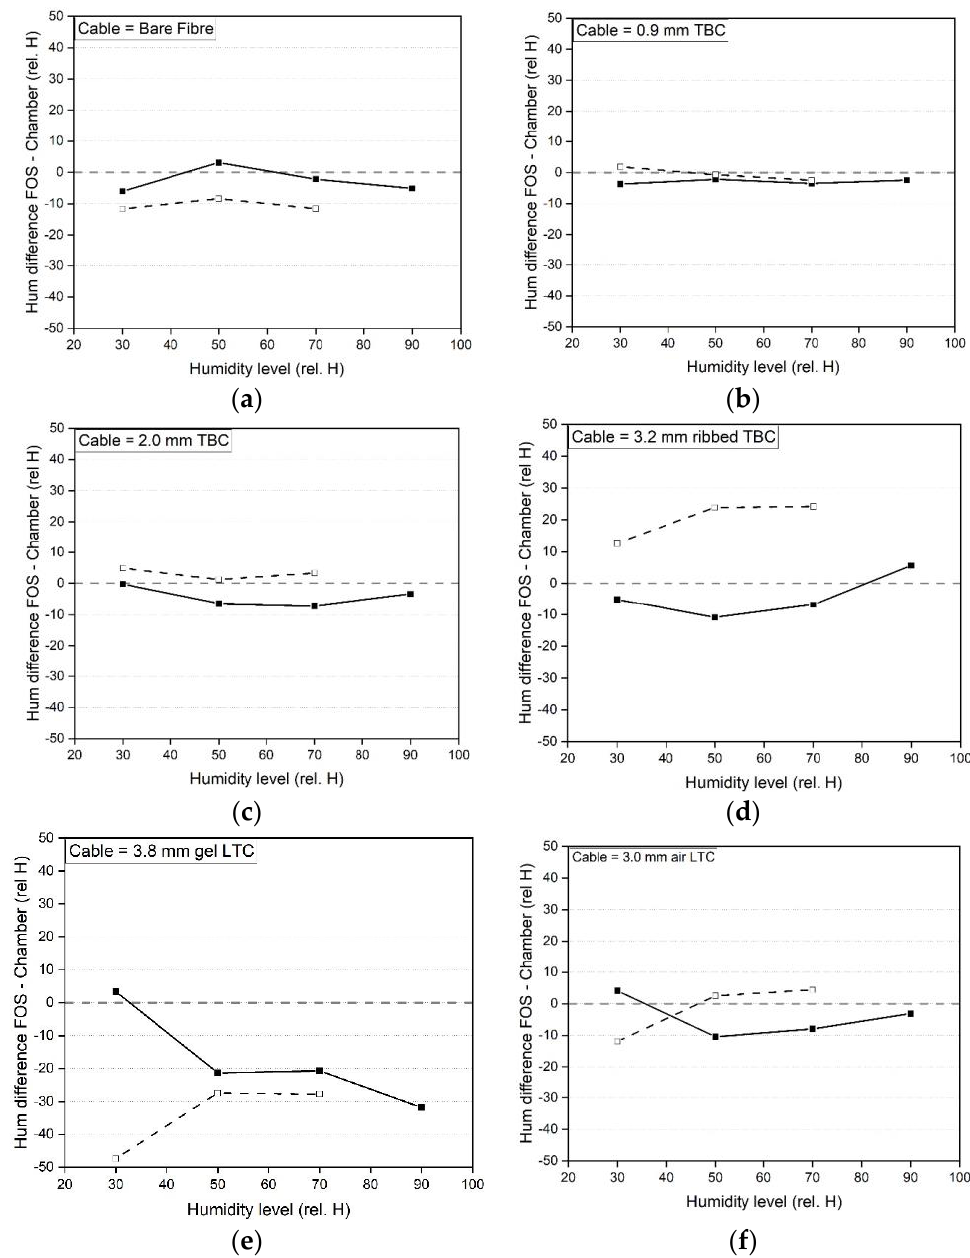
Figure 18. Humidity difference between fibre optic cable and chamber humidity evaluated at each humidity level, ( a ) bare fibre, ( b ) 900 μm tight buffered, ( c ) 2.0 mm tight buffered, ( d ) 3.2 mm ribbed tight buffered, ( e ) 3.8 mm gel filled loose tube and ( f ) 3.0 mm air filled loose tube cable.